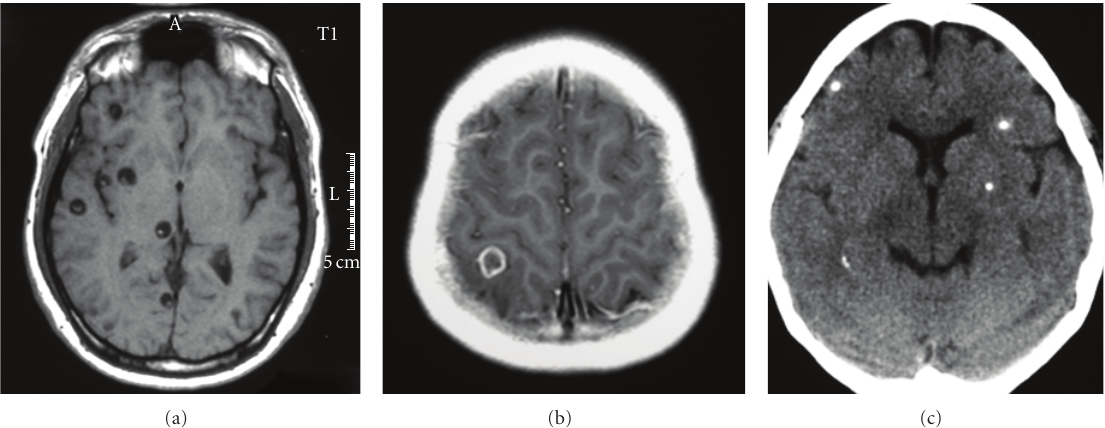
Figure 3: Imaging findings in patients with parenchymal brain cysticercosis, including: viable cysts showing the scolex (a), colloidal cyst appearing as a ring-enhancing lesion (b), and calcifications